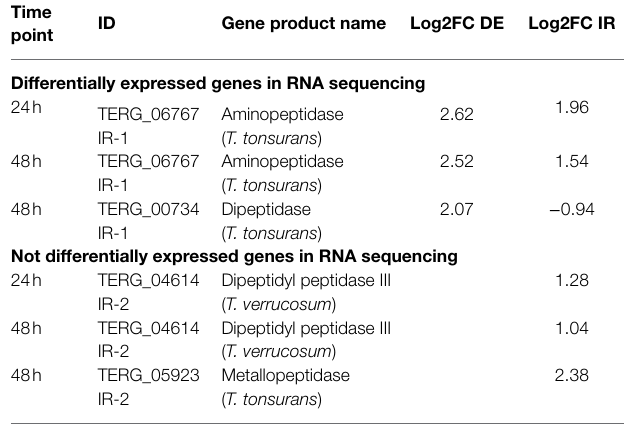
TABLE 1 | Quantification of Intron retention (IR) events in proteases found to be differentially and not differentially expressed in previous RNA